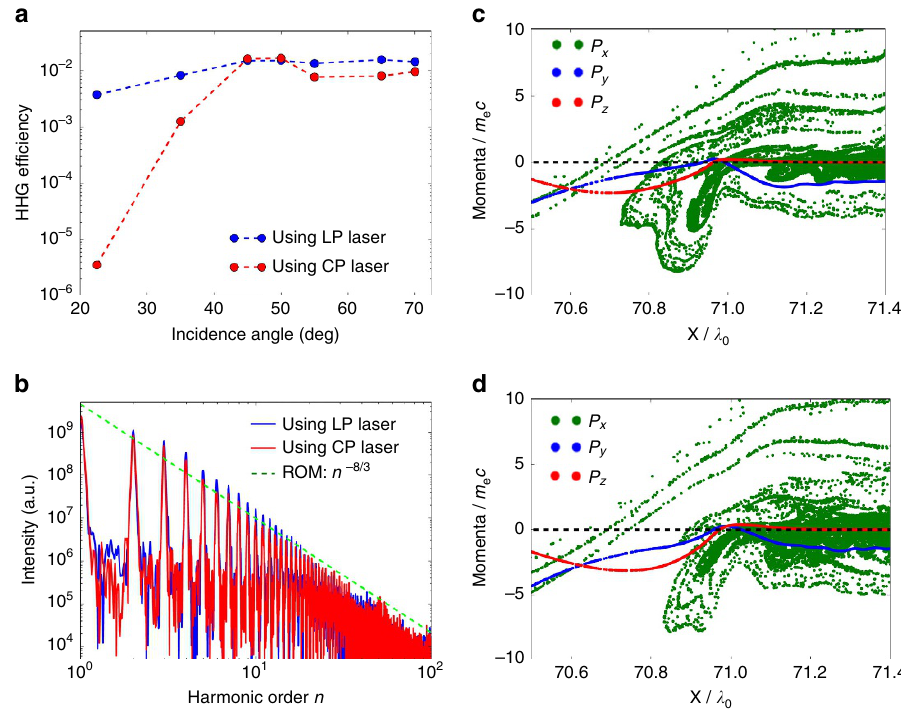
Figure 5 | Harmonic efficiency and plasma dynamics. ( a ) Influence of the incidence angle upon the efficiency of the harmonics (13th–30th) with CP and LP laser pulses. The laser amplitude is a 0 ¼ 5 for the CP laser and a 0 ¼ 7.07 for the LP laser to keep the intensity and pulse energy the same. ( b ) HHG spectra of E y component, compared between the cases using CP and LP laser pulses at 55 (cid:2) incidence. The green dashed line corresponds to the predicted scaling law I ROM ( n ) p n (cid:2) 8/3 by the ROM theory. ( c , d ) Spatial distribution of electron longitudinal ( p x ) and transverse momenta ( p y and p z ) for the case of a CP laser at 55 (cid:2) incidence at two different times of ( c ) t ¼ 28.64 T 0 and ( d ) t ¼ 30.40 T 0 . In these simulations, the other parameters are: laser amplitude a 0 ¼ 5, plasma density n e ¼ 200 n c and scale length L s ¼ 0.1. The momenta are normalized by m e c . The dashed black lines in panels ( c , d ) mark the zero